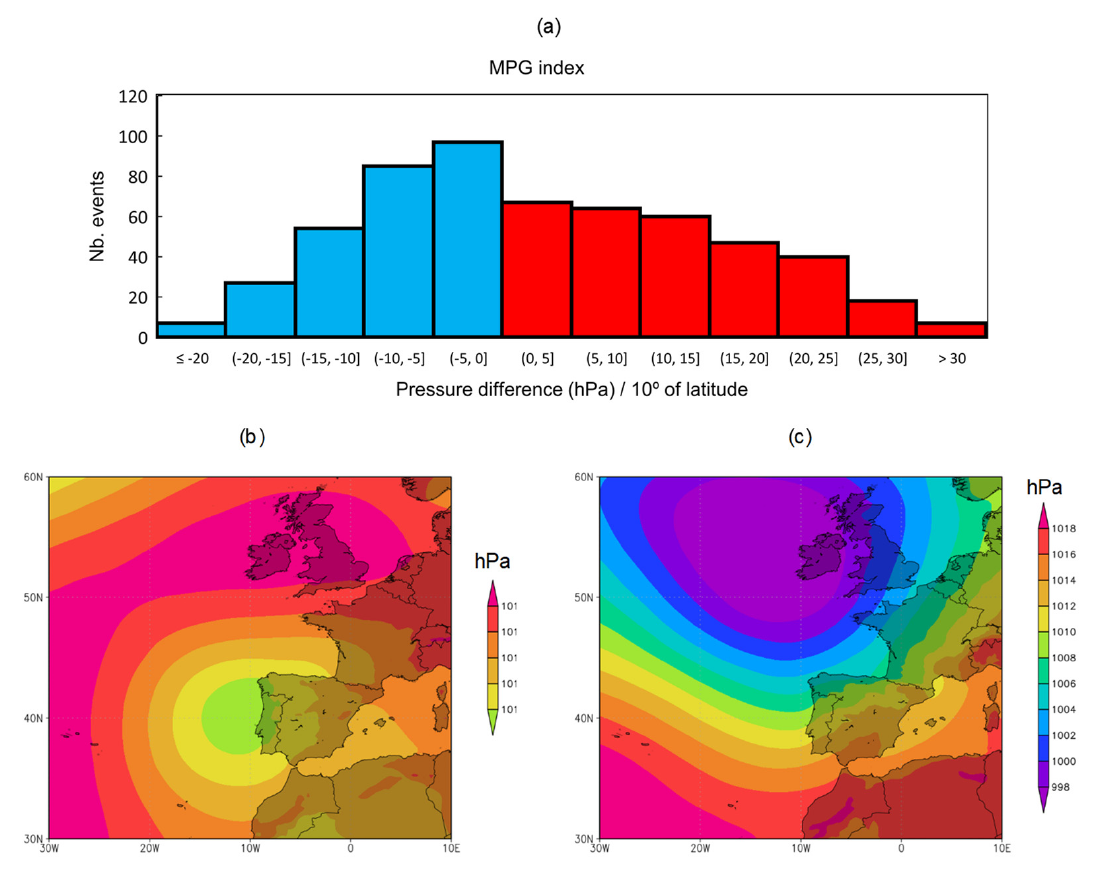
Figure 5. ( a ) Histogram of the distribution of the pressure-gradient index ([SLP40 ◦ N–SLP50 ◦ N] 15–5 ◦ W ) for all SHHP days (573); ( b ) composite of the ERA5 hourly mean sea-level pressure (in hPa) corresponding to the SHHP days for the regional low group (RegL, 269 days). Hourly SLP fields correspond to the hour of occurrence of the severest SHHP event on a given day; ( c ) the composite is the same as in ( b ) but shows data for the remote low group (RemL, 304 days).